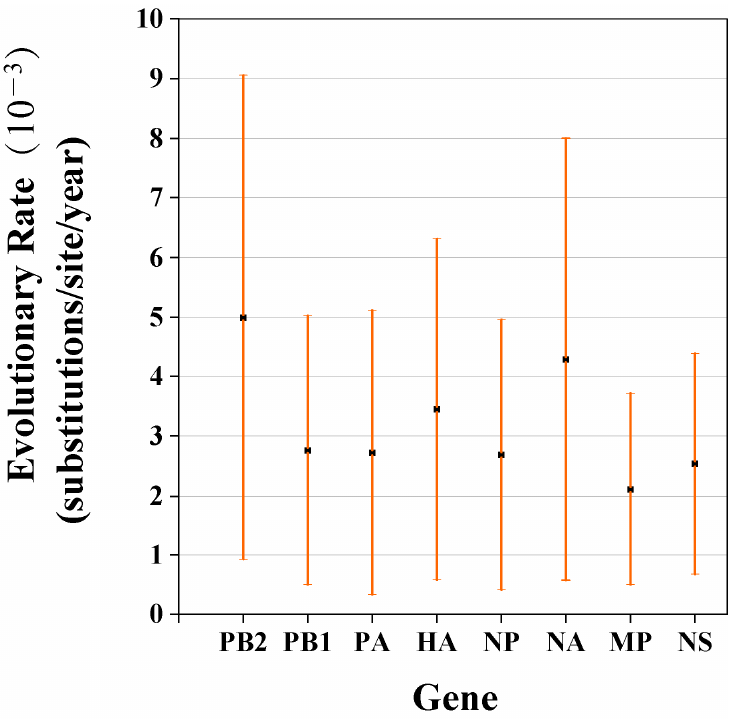
Figure 4. Nucleotide substitution rates for each of the eight segments shown as mean substitution rate for each gene, with the 95% lower and upper HPD values presented as error bars.